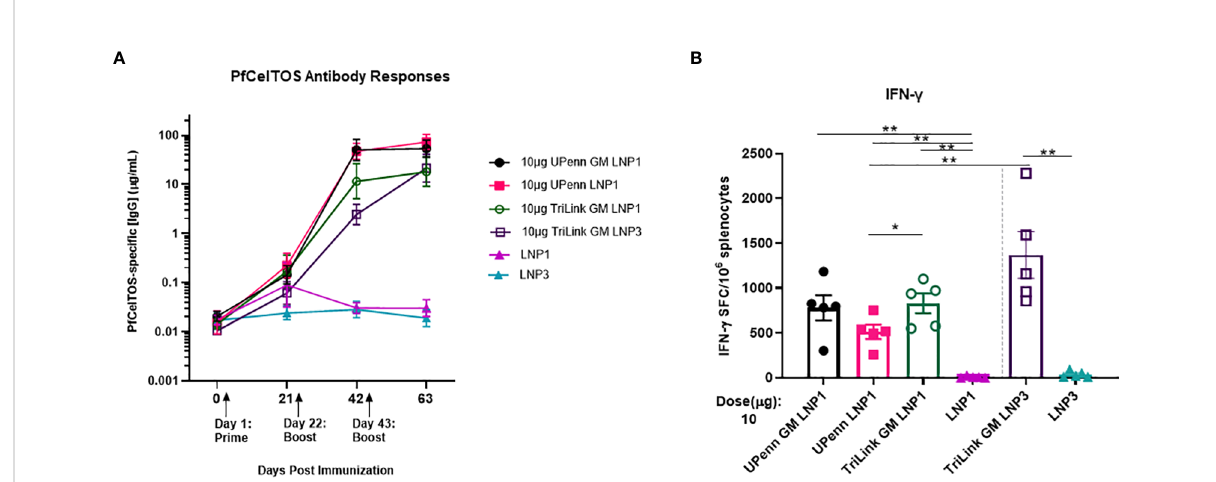
FIGURE 4 A three-dose regime overcomes an “ all-or-none ” pattern for humoral immune responses. Mice were immunized intramuscularly (IM) thrice at a three-week interval with 10µg of University of Pennsylvania (UPenn) N-glycosylation site modi fi ed (GM) and encapsulated in LNP1 (UPenn GM LNP1), or without N-glycosylation modi fi cation (UPenn LNP1) that were one-methylpseudouridine (m1 Y )-5 ′ -triphosphate modi fi ed, and cellulose af fi nity puri fi ed or with TriLink pfceltos mRNA with N-glycosylation site modi fi ed (GM) in LNP1 (TriLink GM LNP1) or LNP3 (TriLink GM LNP3) that were y -pseudouridine and 5-methylcytosine modi fi ed ( n = 15 per group; n = 10 in LNP alone groups). (A) Kinetics of PfCelTOS antibody concentrations measured by ELISA. Antibody concentrations are reported as the geometric mean and 95% con fi dence intervals. (B) IFN- g cytokine responses were detected by ELISpot, (n=5 per group). The mean number of spot-forming cells (SFC) per splenocytes were reported with standard errors of the mean (SEM). Statistical analysis was performed using Mann-Whitney test, (*p<0.05,